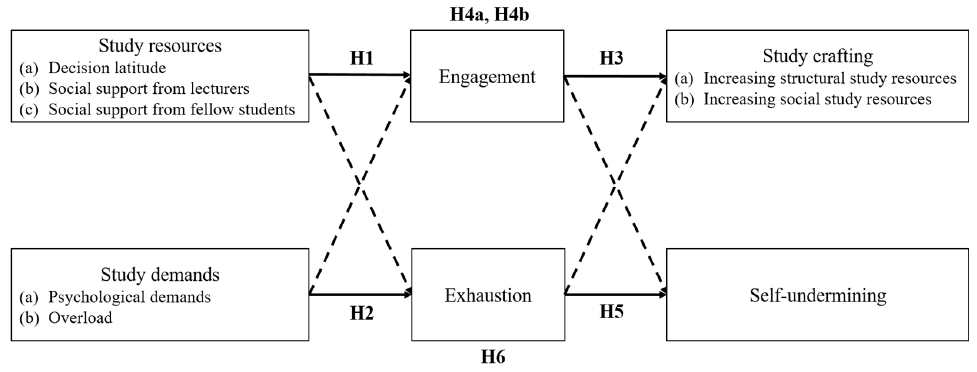
Figure 1. The underlying research model for the weekly relationships.